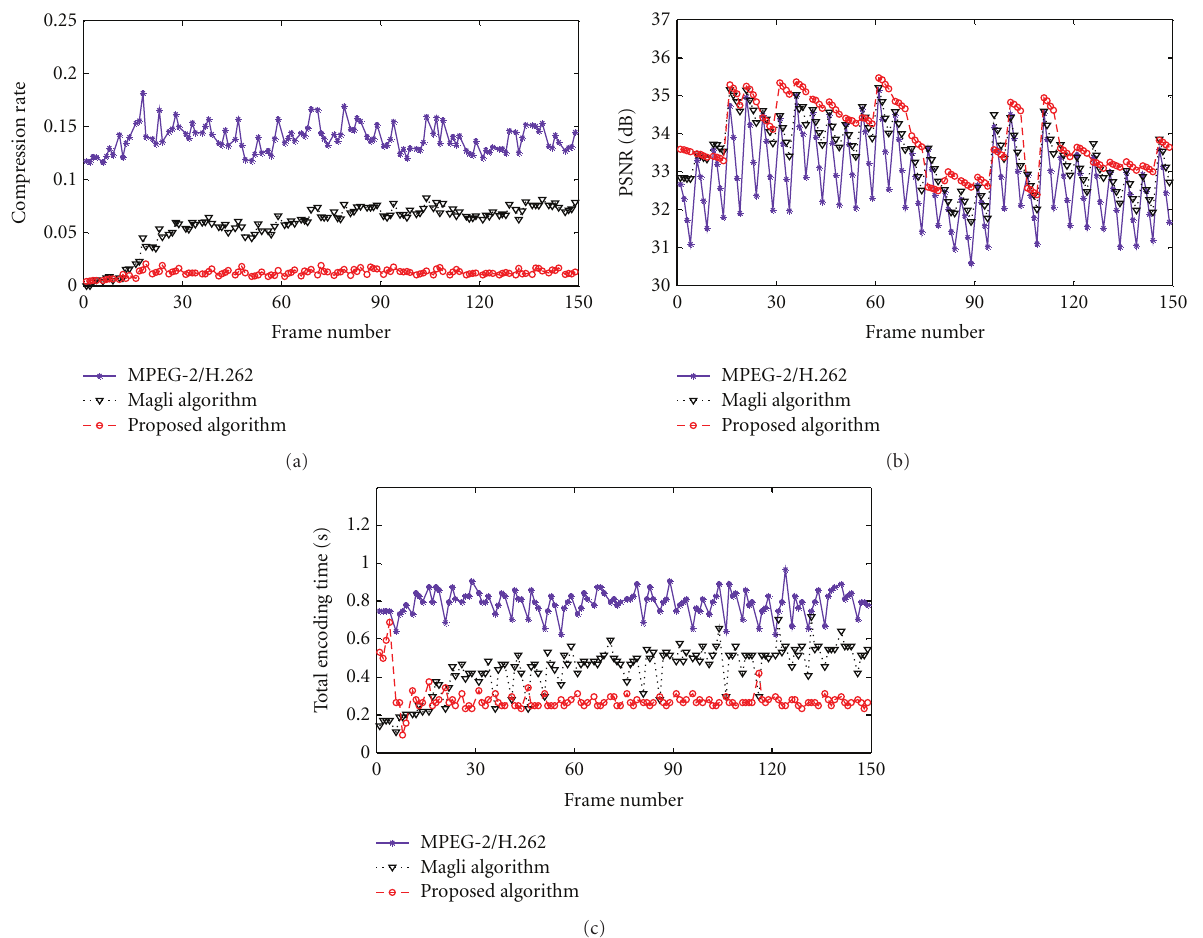
Figure 11: Simulation results with the Akiyo video: (a) the compression rate, (b) the quality of video, and (c) the total encoding time.